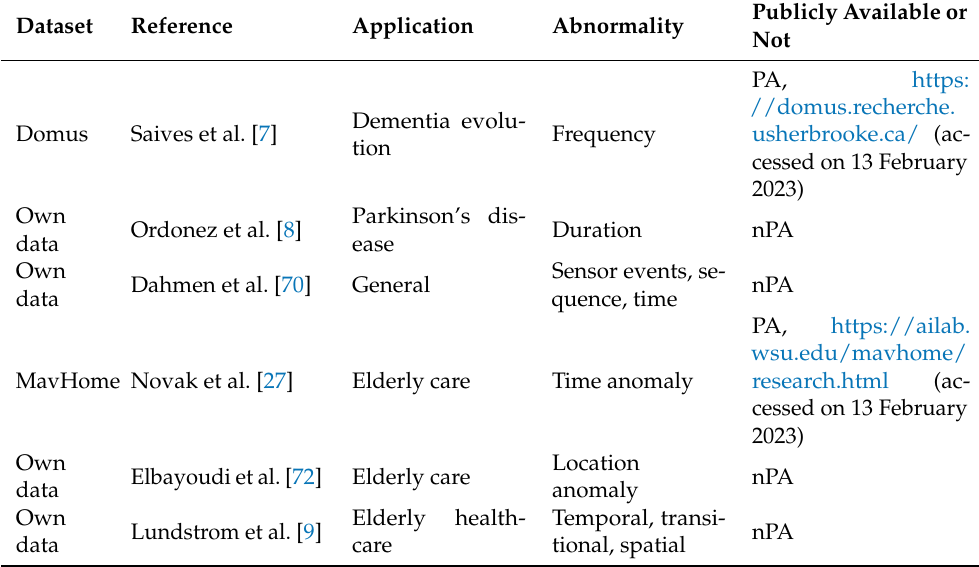
Table 5. A summary of simulated abnormal